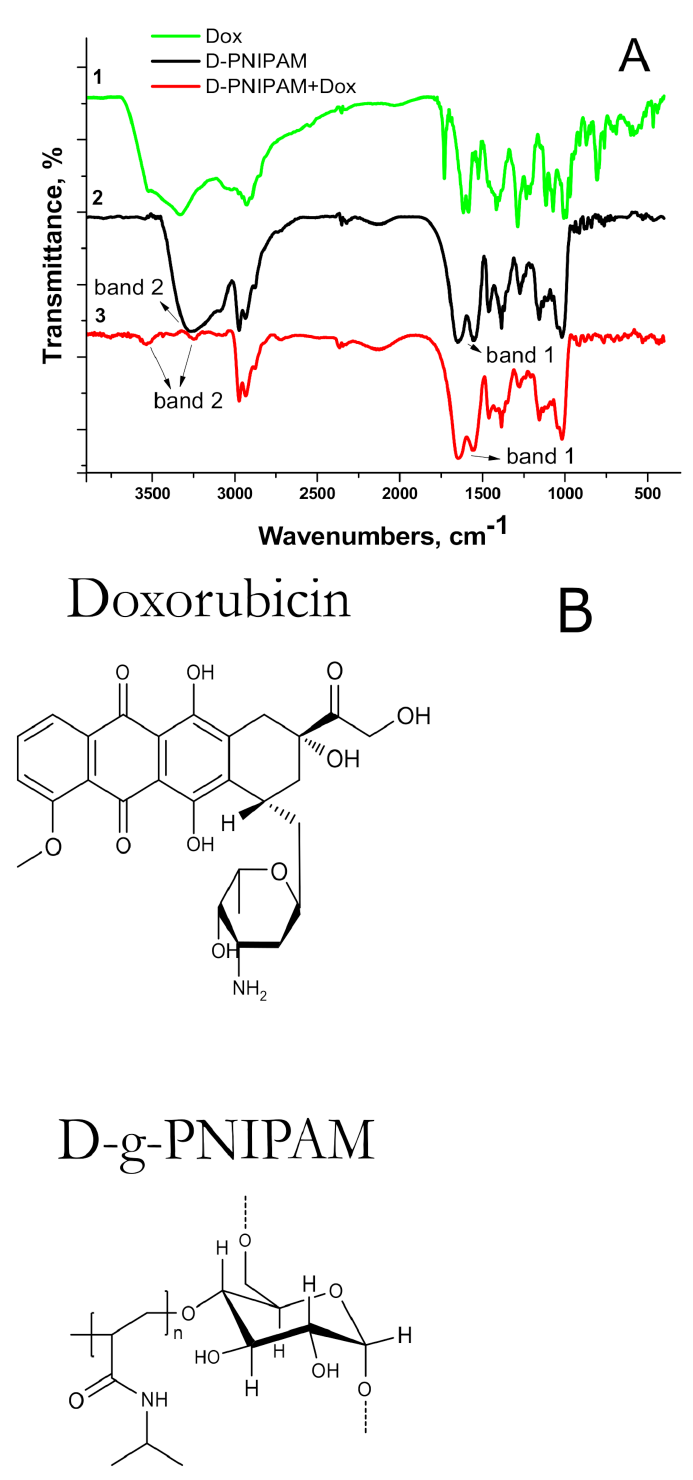
Figure 2. ( A ) FTIR spectra for: 1—Dox (5 µ g mL − 1 ), 2—D-g-PNIPAM (125 µ g mL − 1 ), and